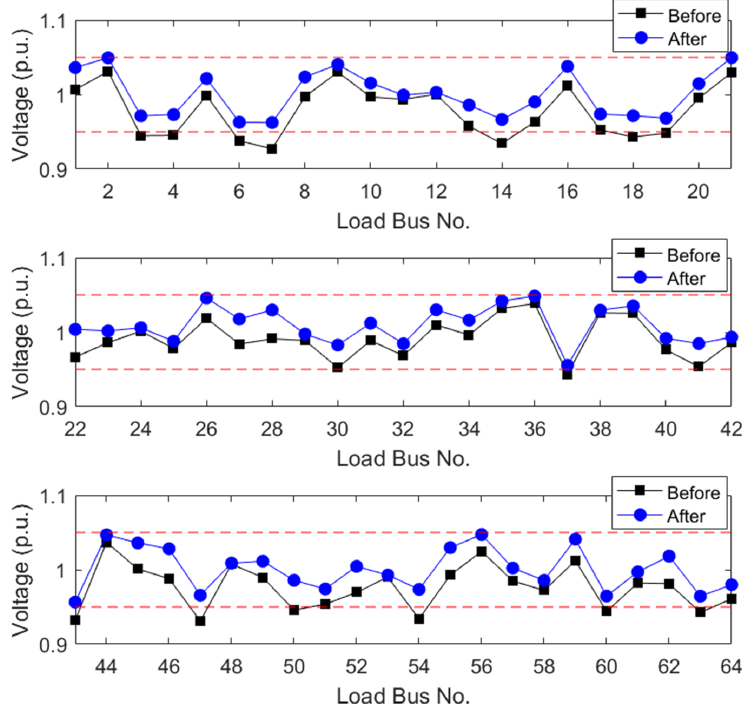
Figure 8. Load bus voltage profile of Case 1 for IEEE 118 ‐ bus.